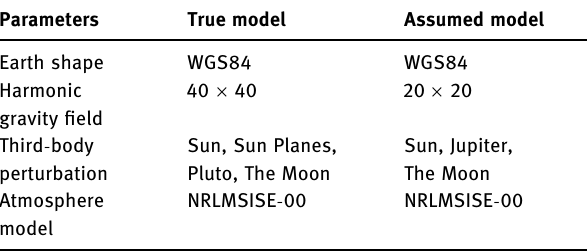
Table 1: Parameters of true dynamic model and assumed